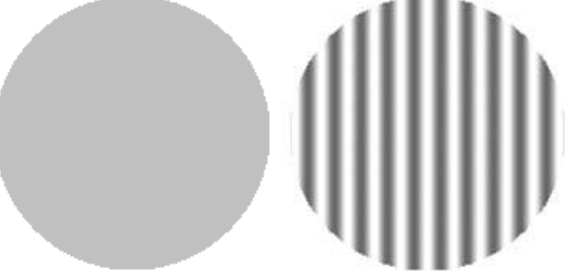
Figura 1. Exemplos de um par de estímulos, à esquerda estímu- lo neutro com luminância média e à direita uma grade senoidal com freqüência espacial de 1,0 cpg. Estímulos originalmente calibrados para serem vistos a 150